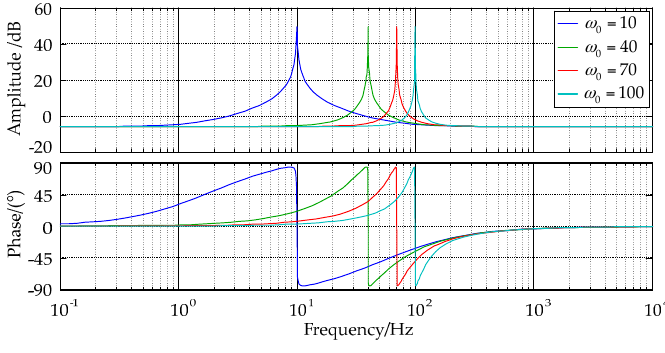
Figure 11. Bode diagram of improved PR controllers with different resonant frequencies.